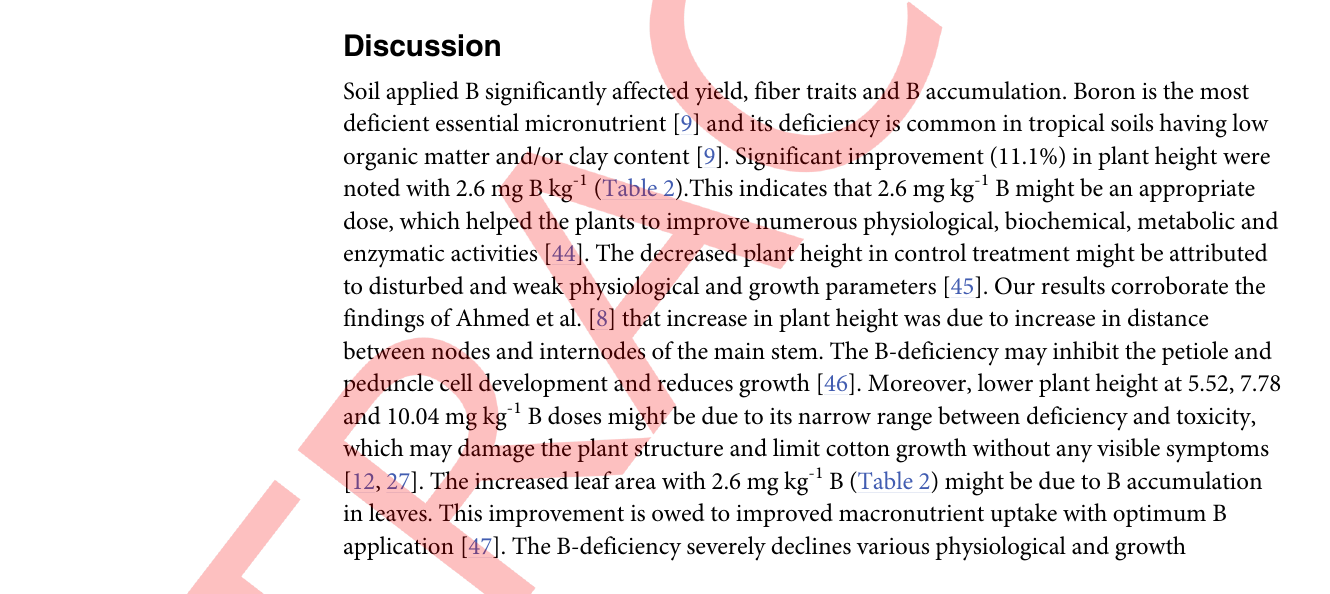
(Table 8). Fiber strength was significantly influenced by the cultivars ( F = 42.62, p = 0.000), B (Table 7). Boron concentration of 2.6 mg kg -1 resulted in 5% higher fiber strength than control (Table 8).